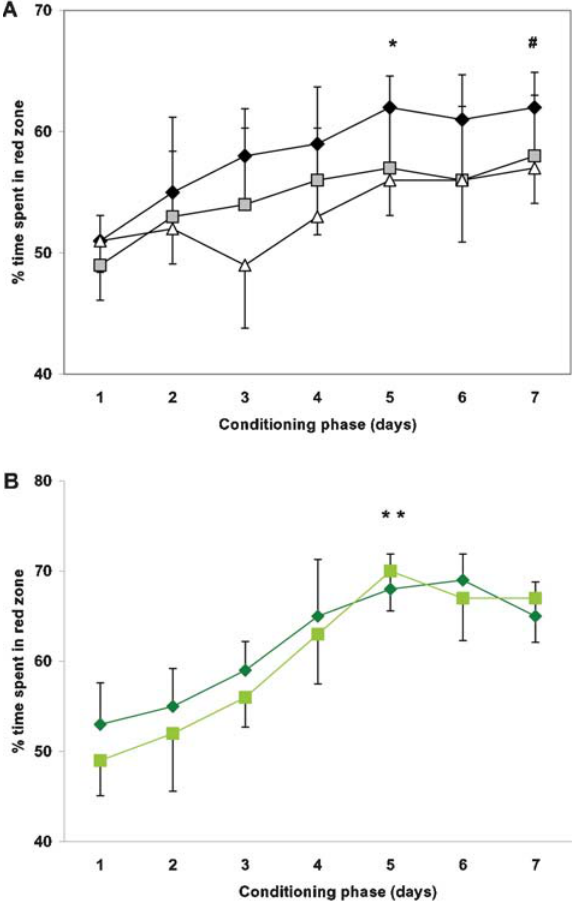
Figure 5. Learning curves in fish of different age: wildtype (A), ACHE mutants (B). Increase in time spent in the red zone during 5 min of red color presentation prior to food administration, compared to the same group behavior at Day 1. Young fish – diamond, middle-aged fish – square, old fish – triangle. First day of significant change in group behavior, * p , 0.01 in young wildtype and mutant fish. # p , .05 in middle-aged wildtype.